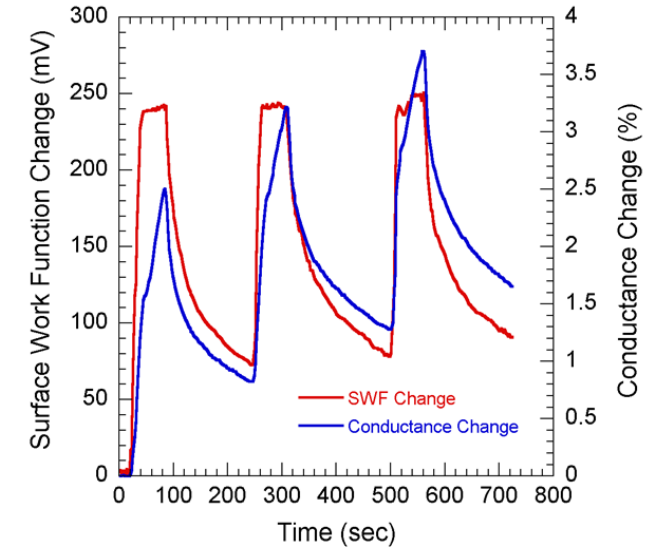
Figure 7: Simultaneous conductance (right axis) and surface work function (left axis) changes measured using NG layer when exposed to 100 ppm NO